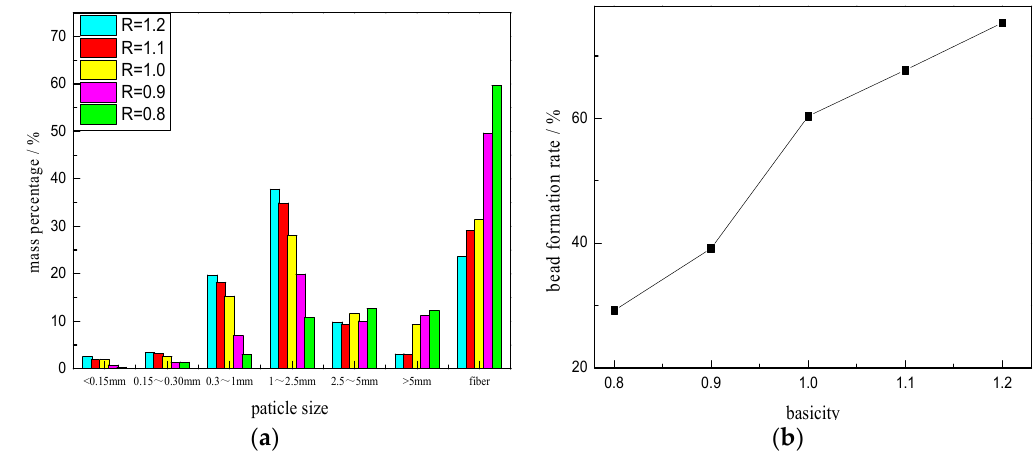
Figure 3. Particle size distribution and bead formation rate of slag beads with different basicities. ( a ) Particle size distribution; ( b ) Bead formation rate.